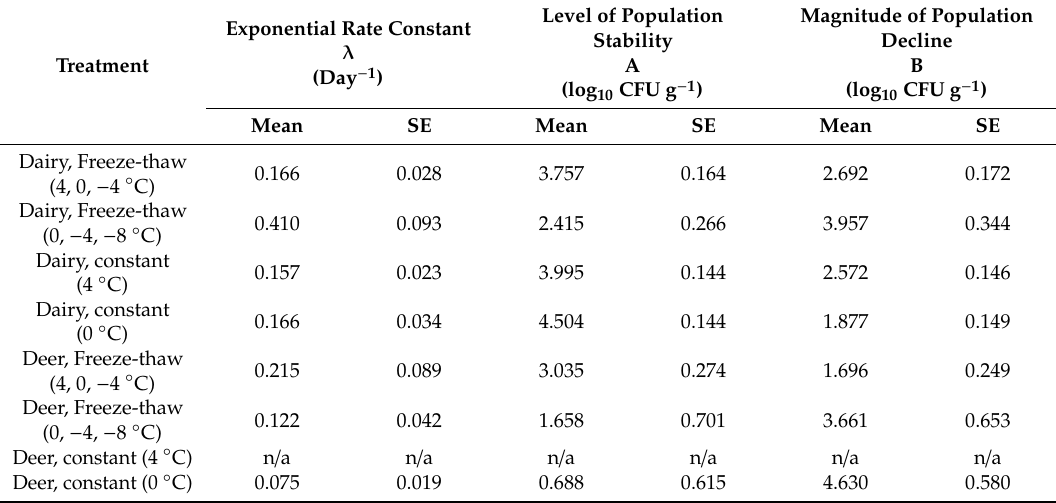
Table 2. Parameter values for E. coli die-o ff associated with non-linear models.